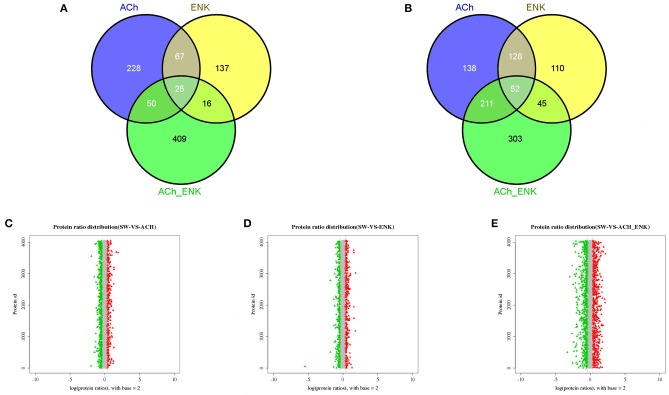
Venn diagrams showing the common and unique up-regulated (A) and down-regulated (B) expressed proteins, and distribution of differentially expressed protein abundances in ACh (C), ENK (D), and ACh_ENK (E) groups. The x-axis indicates the fold change (ratios) of proteins based on the logarithm with base 2. The y-axis indicates the protein ID. The candidate differentially expressed proteins were indicated in red (up-regulated) or green (down-regulated), with the absolute value of log2 (protein fold change) > 1.5.